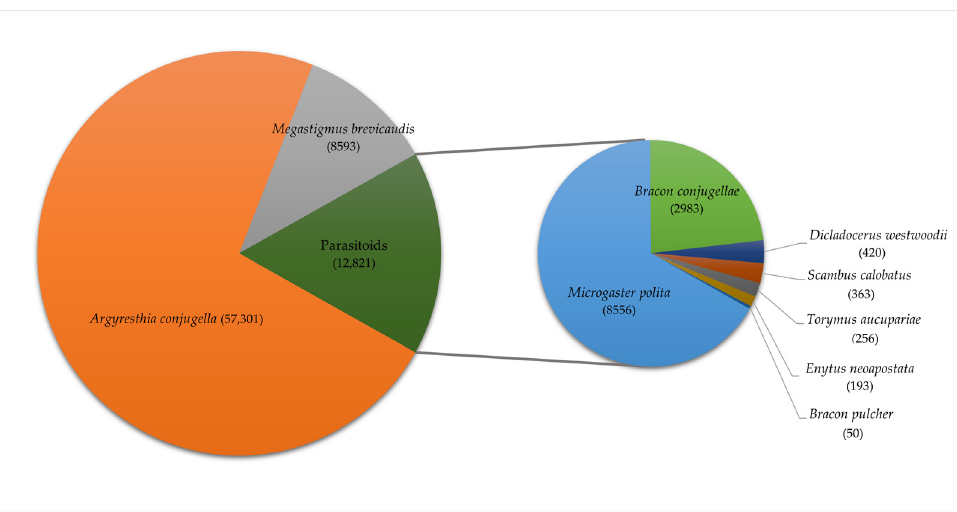
Figure 1. Numbers of the two seed predators and seven parasitoids emerging from rowanberry samples the year after berry collection. Pooled data for berry samples collected 1977–1981 and used for EIS-mapping. The two species of Bracon were not separated before 1980.